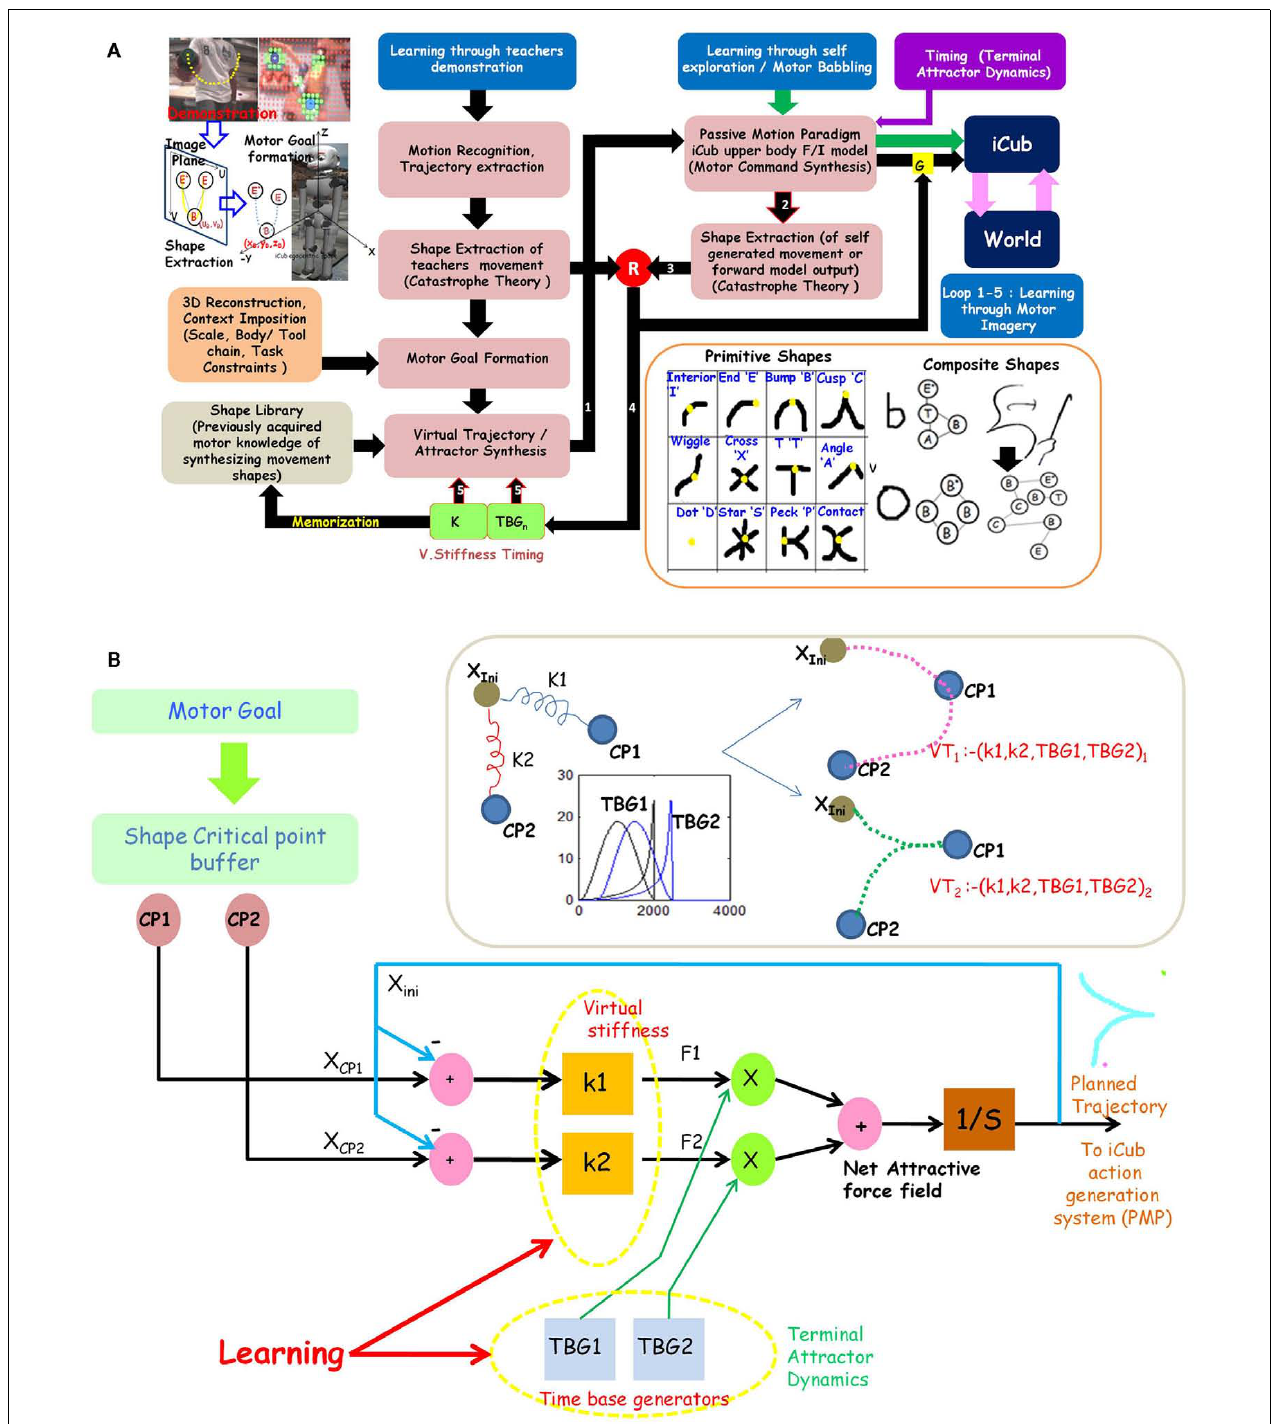
stiffness matrices (K1 and K2).The two force fields are activated in sequence, with a degree of time overlap, as dictated by two time base generators (TBG1 andTBG2). Simulating the dynamics with different values of K and γ , results in different trajectories through the critical points. Inversely, the problem of learning is to acquire the correct values for K and γ (virtual stiffness and temporal overlap) such that the shape of the resulting trajectory correlates with the shape description in the motor